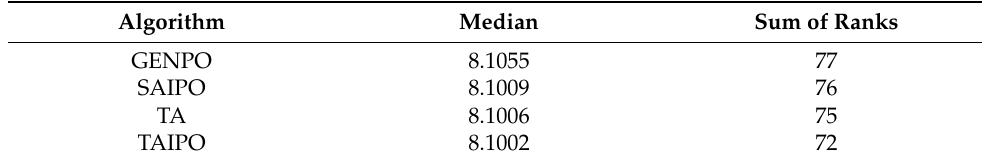
Table 11. Friedman Test for best algorithms with MARR